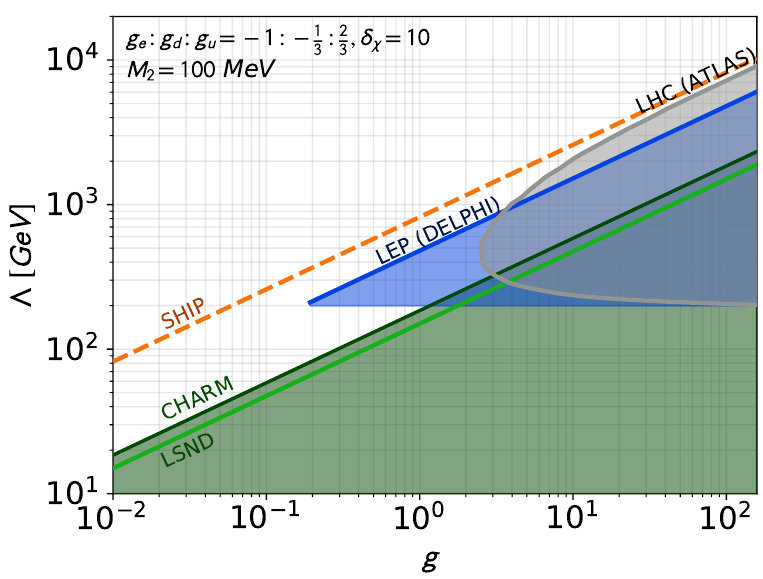
Figure 7 . Limits and prospective experimental sensitivity when varying the overall scaling g for M (cid:31) = 100 MeV for the vector-current operator as a function of M 2 (cid:29) M 1 on the x-axis. Exclusion from LSND [63] (CHARM [46]) are shown in green, as well as 10 events reach by SHiP in dashed orange. The shaded blue region is the mono- (cid:13) limit from LEP [72]. The grey region is the exclusion from ATLAS mono-jet [73]. The normalised splitting (cid:14) (cid:31) is de(cid:12)ned in eq. (2.4).